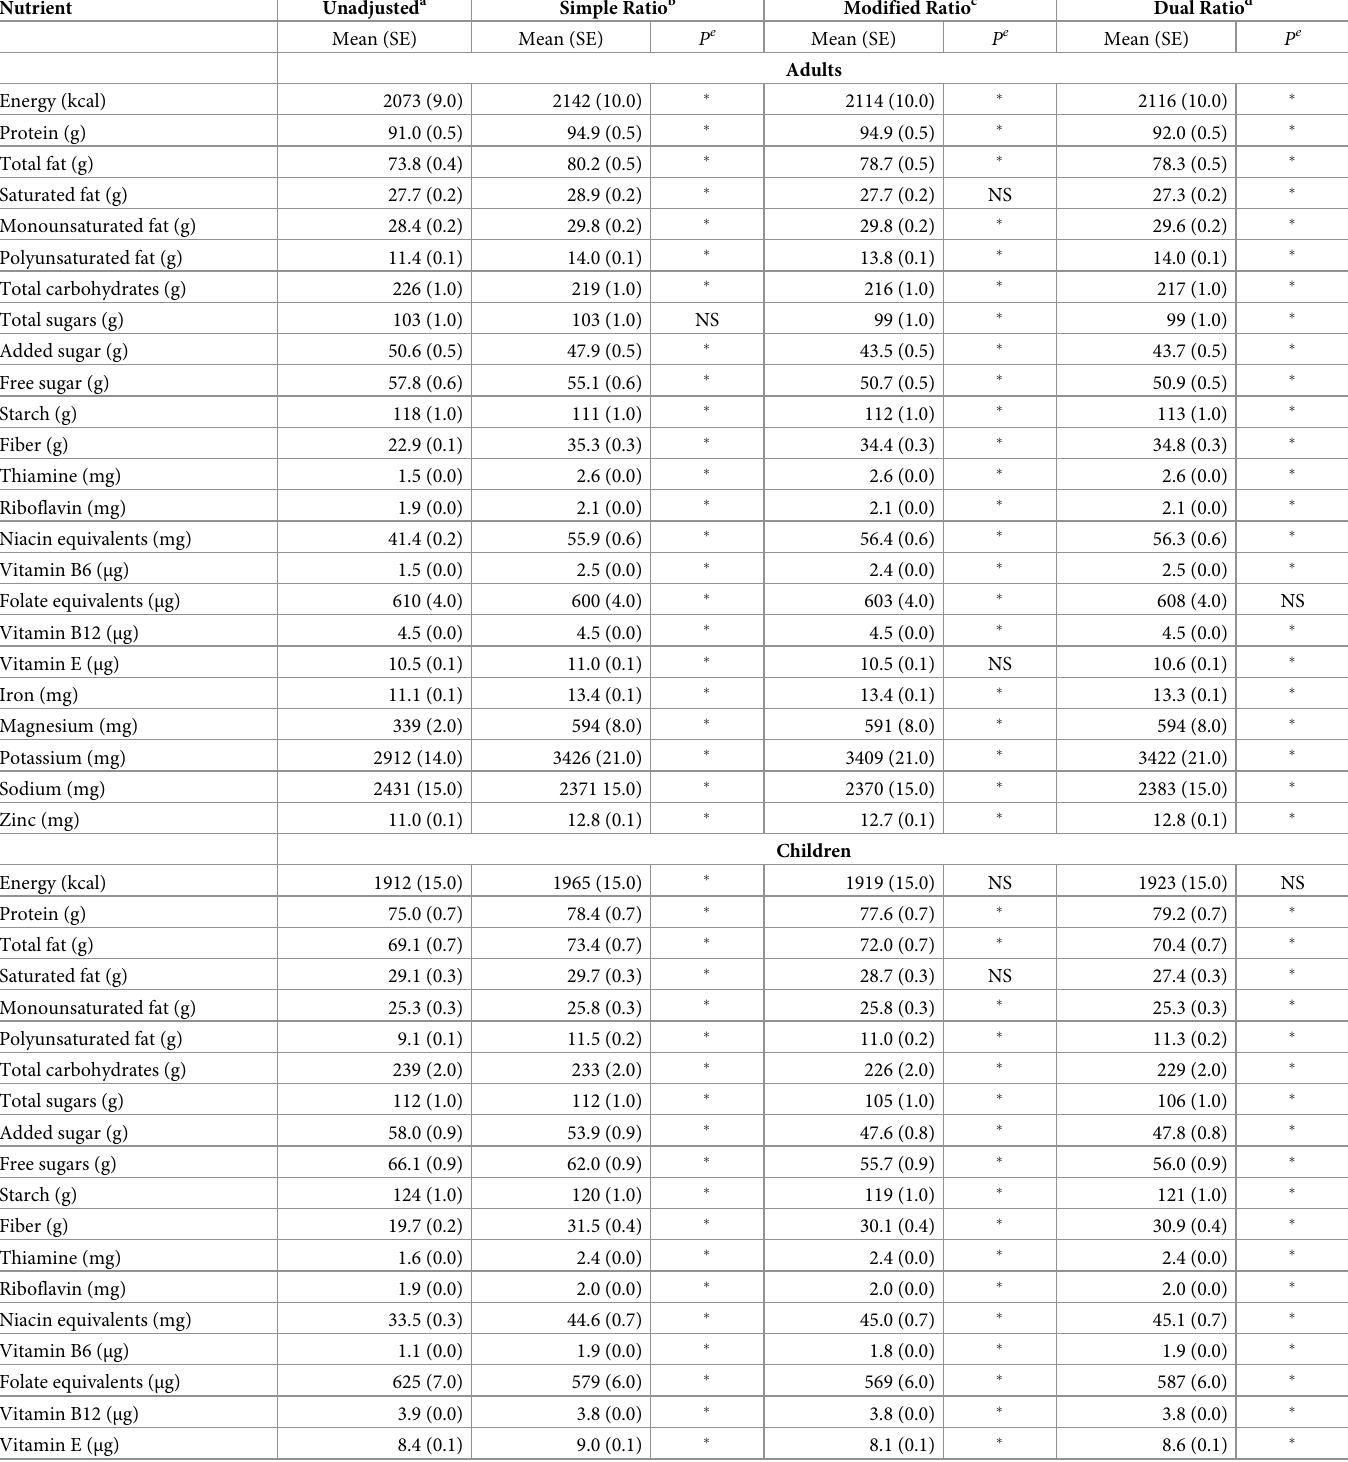
Table 5. Dietary modelling of the impact of substituting carbohydrate foods that meet each carbohydrate quality ratio in place of foods that do not, on nutrient intakes for adults and children.